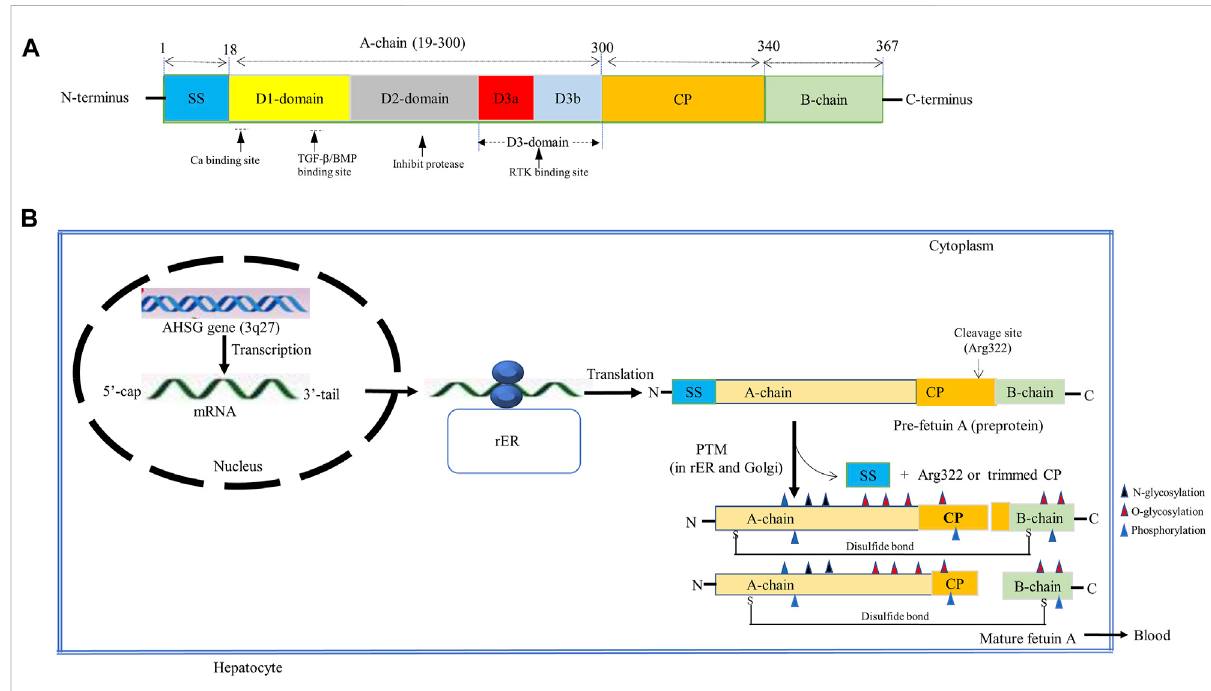
FIGURE 1 Schematic representation of (A) Fetuin-A structure. The pre-fetuin-A contains 367 amino acids, including 18 amino acid size SS (Pedersen, 1944; Brown et al., 1992; Dziegielewska and Brown, 1995; Brown and Dziegielewska, 1997; Olivier et al., 2000; Denecke et al., 2003; Kettler et al., 2003; Stefan et al., 2006a; Häusler et al., 2009; Wojtysiak-Duma et al., 2010; Jahnen-Dechent et al., 2011; Mori et al., 2012; Dietzel et al., 2013; Cerdà-Costa and Xavier Gomis-Rüth, 2014; Stöcker et al., 2014; Floehr et al., 2016; Lin et al., 2018; Sardana et al., 2021); 282 amino acids A-chain (19 – 300), 40 amino acids CP (301 – 340), and 27 amino acids long B-chain (341 – 367). A-chain is composed of two cystatin-like domains (D1 and D2) and a variable non-cystatin domain, D3 (D3a and D3b). Functionally, the D1 provides binding sites for calcium, TGF- β , and BMP, the D2inhibits cysteine protease and D3interactswith theinsulinreceptor. (B) Fetuin-A biosynthesis. Fetuin-A isencoded bytheAHSG gene located on the 3q27 locus that produces a single copy of mRNA encoding a pre-fetuin-A. The pre-fetuin-A consisting of SS, A-chain, CP, and A-chain undergoes PTMs (glycosylation, proteolysis, folding, and phosphorylation). Glycosylation takes place at Asp residues (N-glycosylation), Thr and Ser residues (O-glycosylation). Then SS and Arg322 will be removed through proteolysis with certain unknown proteinase to form a mature fetuin-A containing a full length of CP apart from Arg322 or C-terminally trimmed CP, interlinked by a disul fi de bond formed between Cyst-14 and Cys-340. Then phosphorylation at multiple Ser and Thr residues, mostly in plasma, occurs by FAM20C. Abbreviations: AHSG, α 2-Heremans-Schmid glycoprotein; BMP, Bone Morphogenic protein; CP, connecting peptide; FAM20C, family with sequence similarity 20 member C; PTMs, post- translational modi fi cations; rER, rough endoplasmic reticulum; RTK, receptor tyrosine kinase; SS, signal sequence; TGF- β , Transforming growth